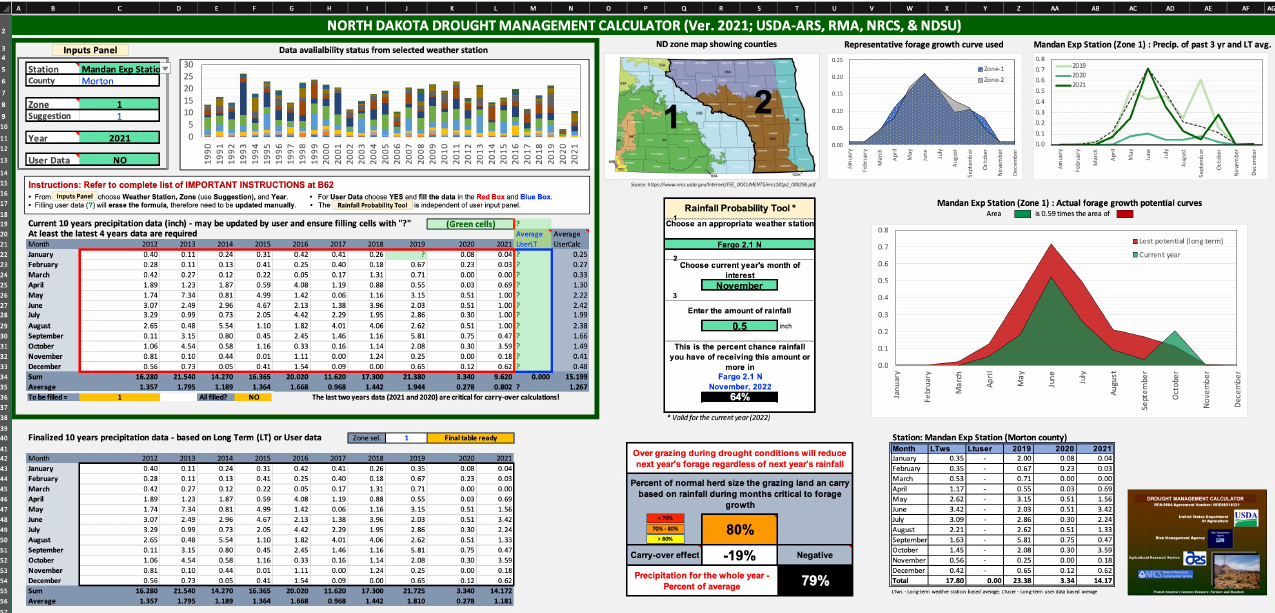
Figure 6. No-macro Updated North Dakota Drought Calculator (UNDDC) dashboard for predicting forage growth potential using monthly precipitation for two growth zones. The green cells indicate input fields; the red, orange, and yellow are color codes for the indicated ranges of percent of normal herd size; and black cells with white text are respective